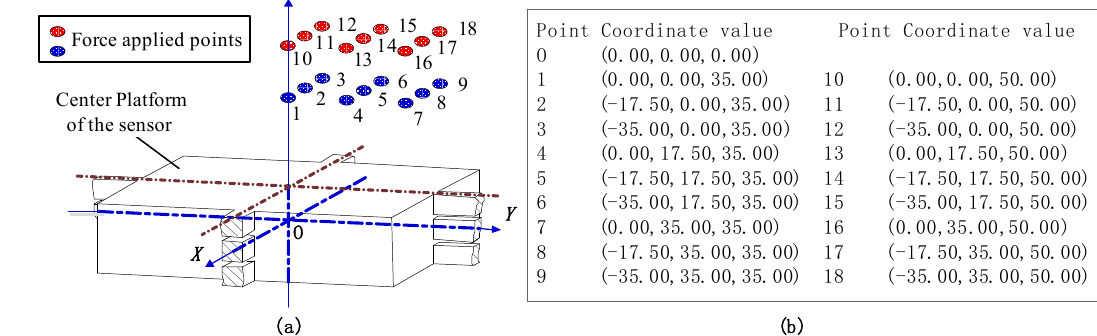
voltage values with maximal differences are listed in Table